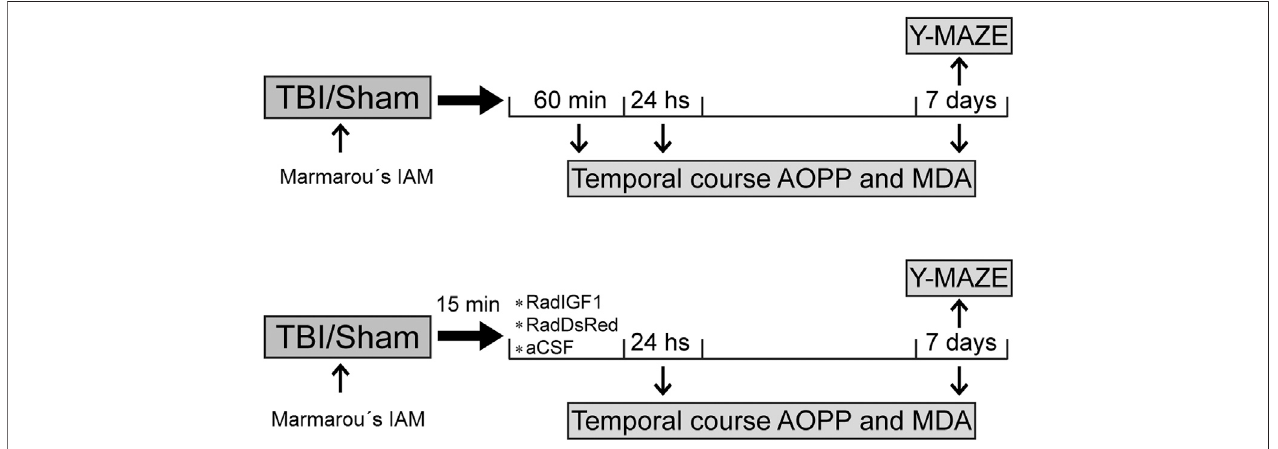
FIGURE 1 | Experimental design. Chart illustrating our experimental design including Marmarou ’ s impact acceleration model (Marmarou´s IAM), viral vectors administration, temporal course of protein (AOPP) and lipids (MDA) peroxidation, and neurobehavioral assesements (Y-Maze